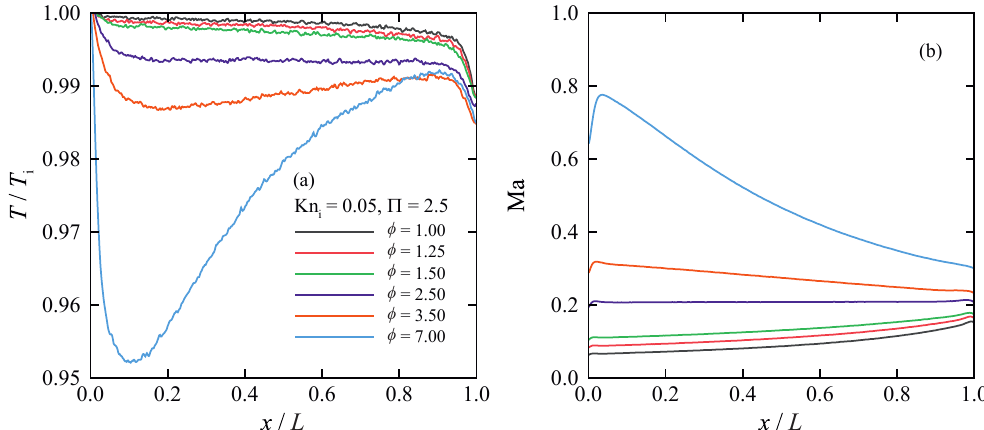
Figure 4. Distribution of ( a ) gas temperature and ( b ) Mach number along the microchannel centreline for different divergence angles φ (Kn i = 0.05 and Π = 2.5). The inlet temperature ( T i ) is used to non-dimensionalise the predicted